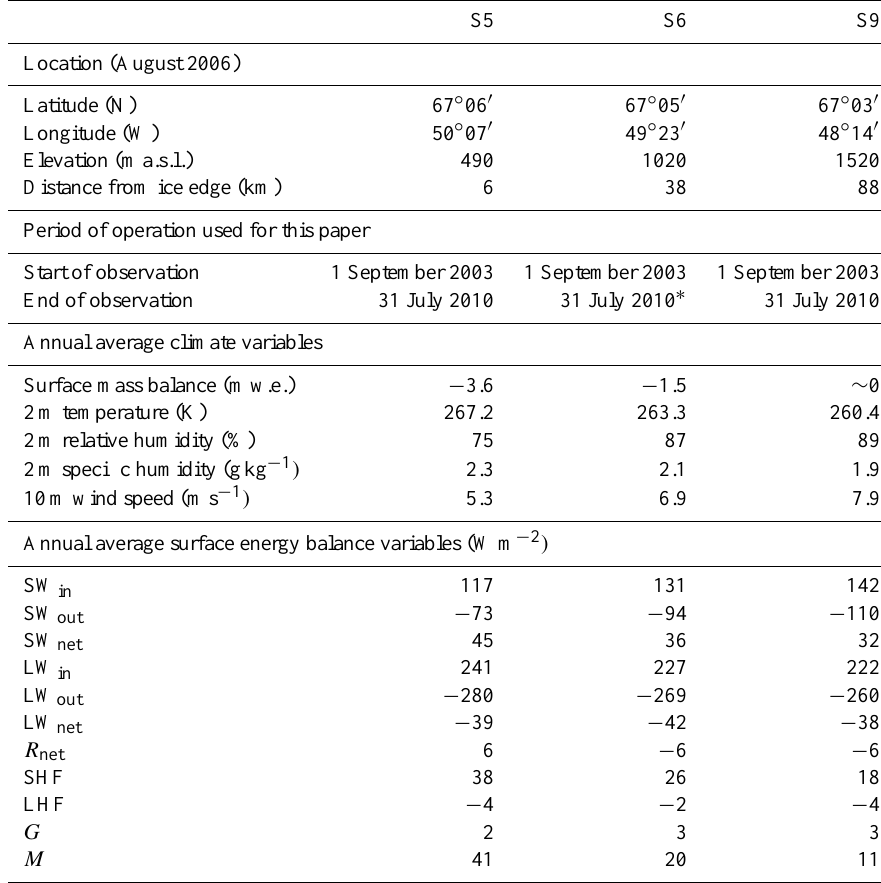
Table 2. AWS topographic, climate and surface energy balance characteristics. Similarity theory is used to obtain temperature, humidity and wind speed at standard heights from AWS observations. All SEB values are derived from the SEB model apart from SW in , SW out and LW in , which are from (corrected)